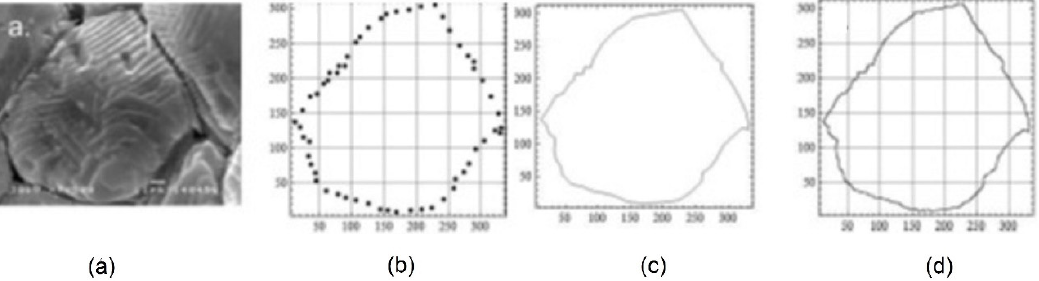
Figure 4. Grain structure reconstruction using fractal interpolation. ( a ) Experminetaly obtained image, ( b ) Extracted contour, first iteration, ( c ) Upgraded contour, ( d ) Final result obtained using